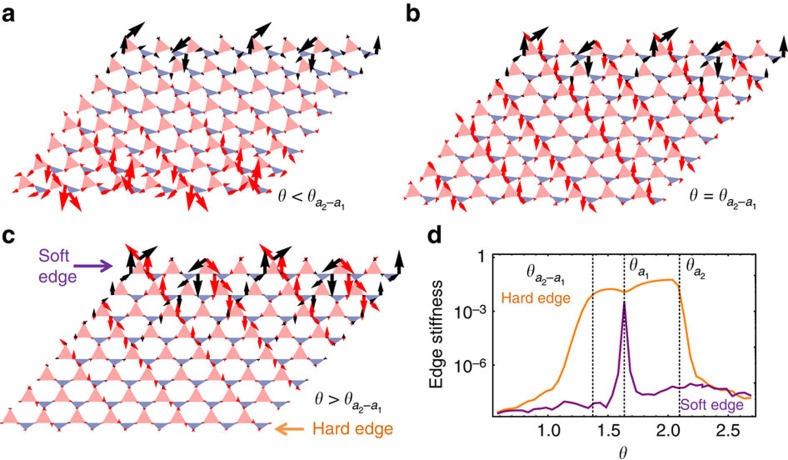
Transformation of edge modes and stiffness.(a–c) Evolution of a pair of floppy modes (red and black arrows) as the example deformed kagome lattice shown in Fig. 1 traverses its soft twisting coordinate θ across the critical angle , where the lattice develops a topological polarization. Periodic boundary conditions are applied to left-right edges and open boundary conditions to top-bottom edges. (d) Numerical results for the dramatic change of stiffness of the hard (bottom) edge against local displacements as θ changes and floppy modes move to the opposite edge. Data is from a 60 × 60 generic kagome lattice with the structure shown in (a) with free hinges and fixed boundaries except the measurement edge (see Supplementary Note 1).